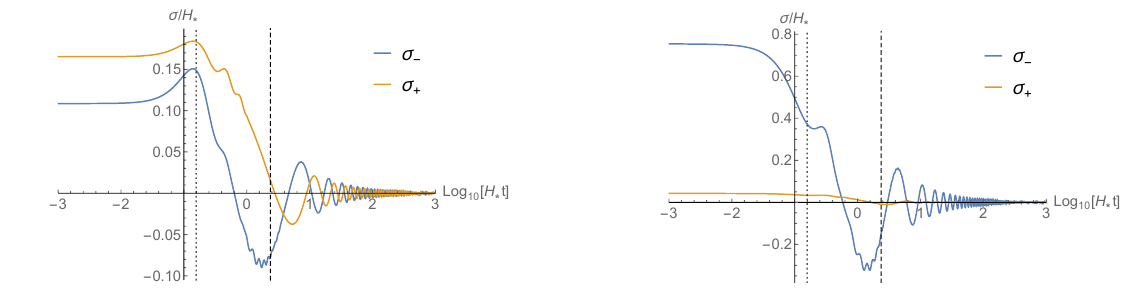
Figure 4 . The time evolution of mass eigenstates σ ± from the end of inflation to radiation domination with m = 20 H , Λ = M , H = 2 . 37 × 10 13 GeV and Γ = 10 13 GeV. In both panels I ∗ P ∗ I N ∗ = 1 and N end = 5 are used. The vertical dotted lines are t = π/m I and the vertical dashed lines are t = 1 / Γ . Left panel: the case of tachyonic initial masses with { c = {− 2 , 1 , 1 } and I 1 , c 2 , c 3 } m σ = H ∗ / 2 . Right panel: the case of positive masses with { c 1 , c 2 , c 3 } = { 2 , − 1 , 1 } and m σ = H ∗